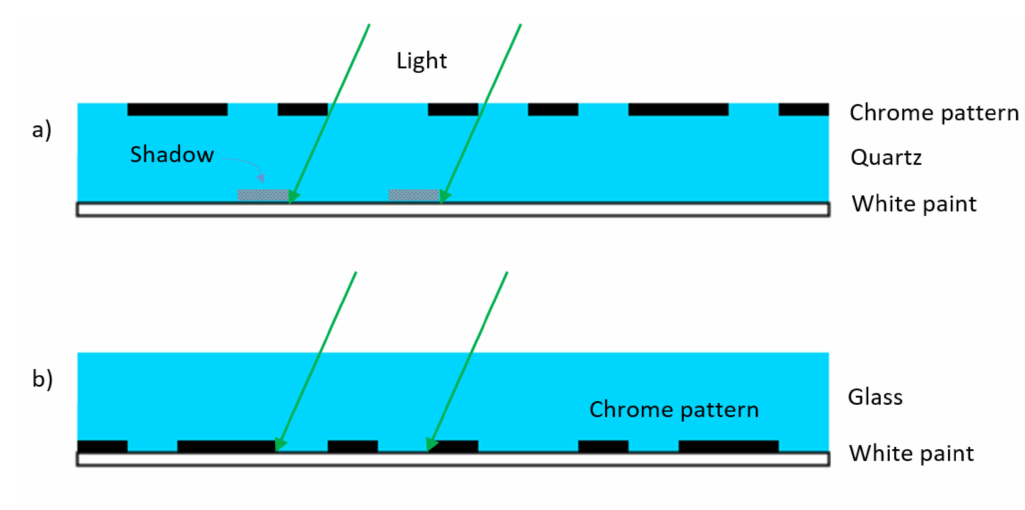
Figure 5. Vertical section sketch of two scales: ( a ) scale made out of quartz with white backing on the side opposite to the metal patterns, and ( b ) scale made out of float glass, with white backing on the side with the metal